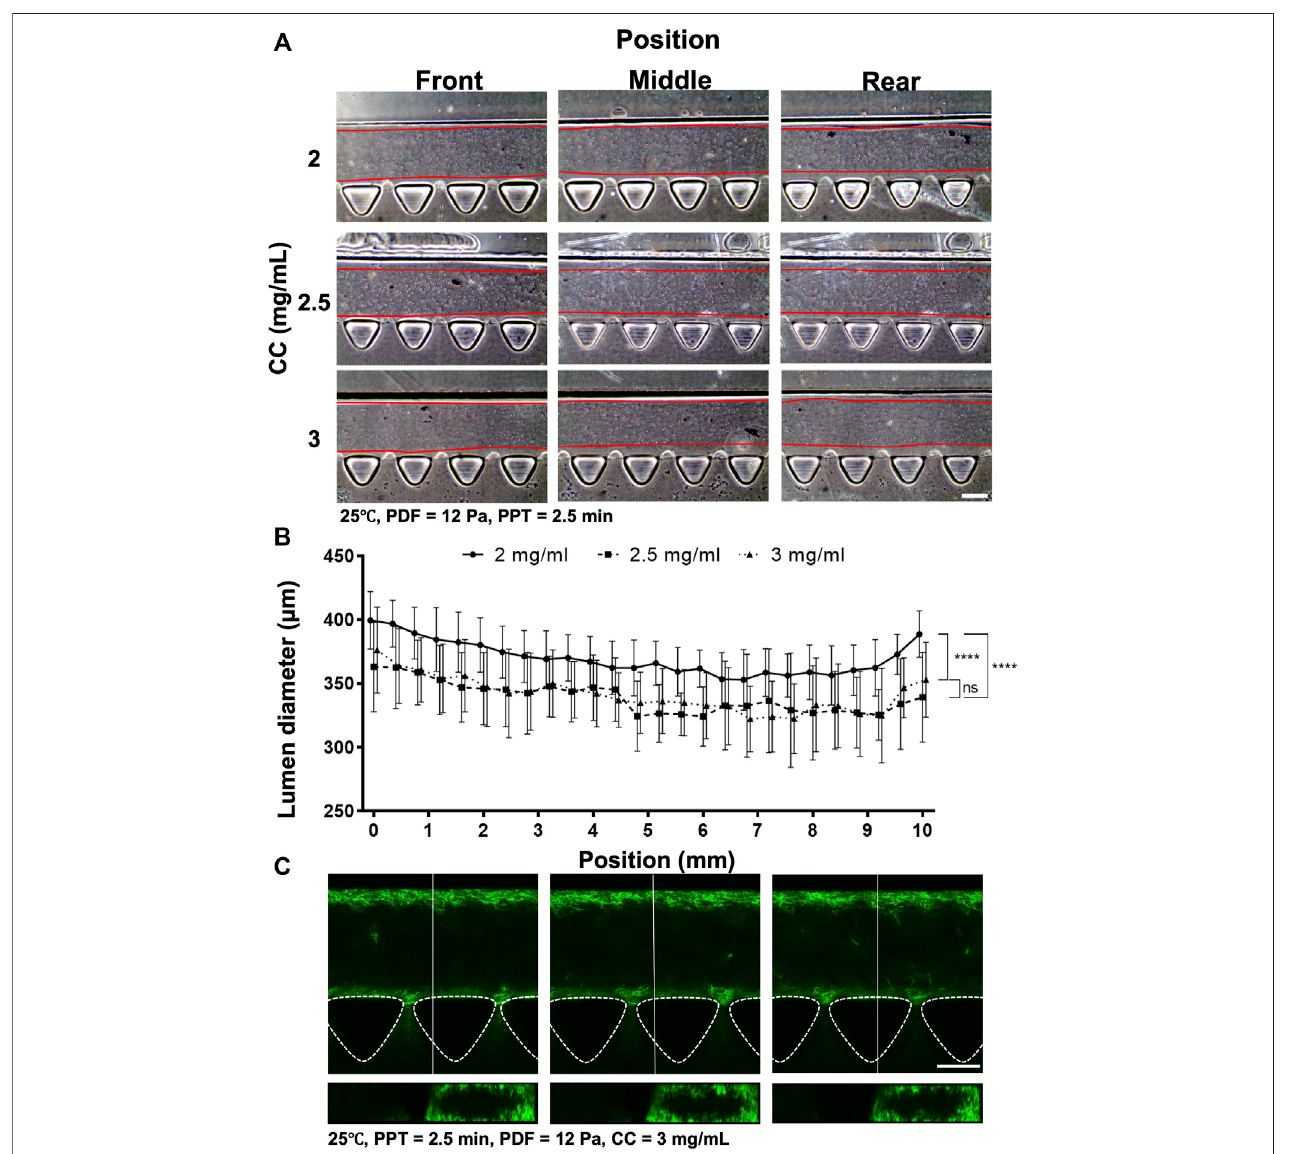
FIGURE5| Comparison ofthecollagenlumenformedatdifferentCCsat2,2.5,and3 mg ml − 1 ,wherethetemperaturewassetat25 ° C,PDFat12 Pa,andPPTat 2.5 min. (A) Morphology of the collagen lumen formed at different locations of the media channel at different CCs. (B) Quanti fi cation of the average collagen lumen diameter at different locations in the media channel. (C) Top- and cross-sectional views of the fl uorescently labeled collagen lumen (3 mg ml − 1 ). Scale bar: 200